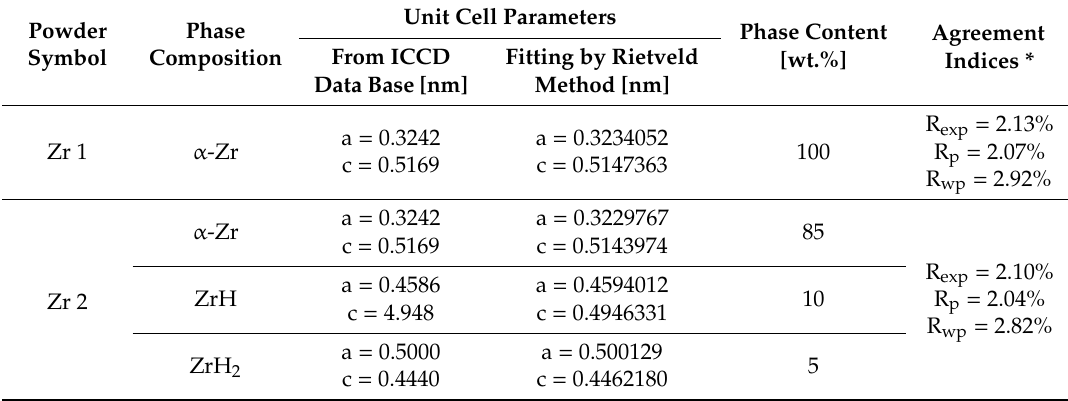
Phase Content Agreement [wt.%] Indices *From ICCD R exp = 2.13% R p = 2.07% 100 R wp = 2.92% 85 R exp = 2.10% 10 R p = 2.04% R wp =